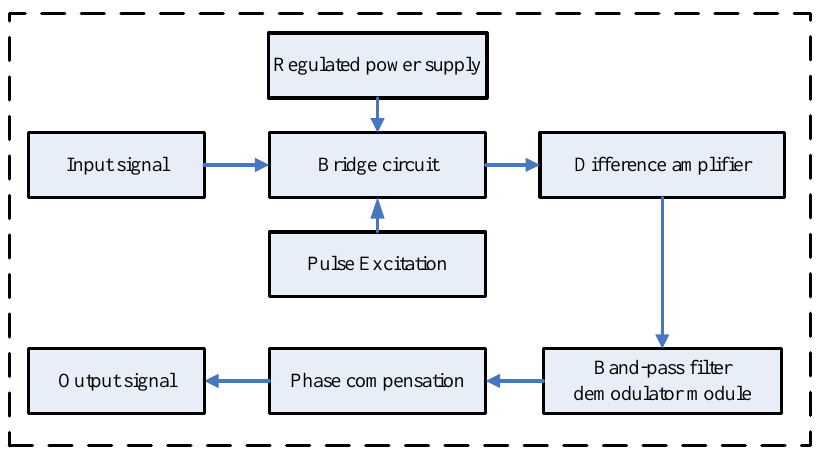
Figure 4. The gyroscope signal pretreatment